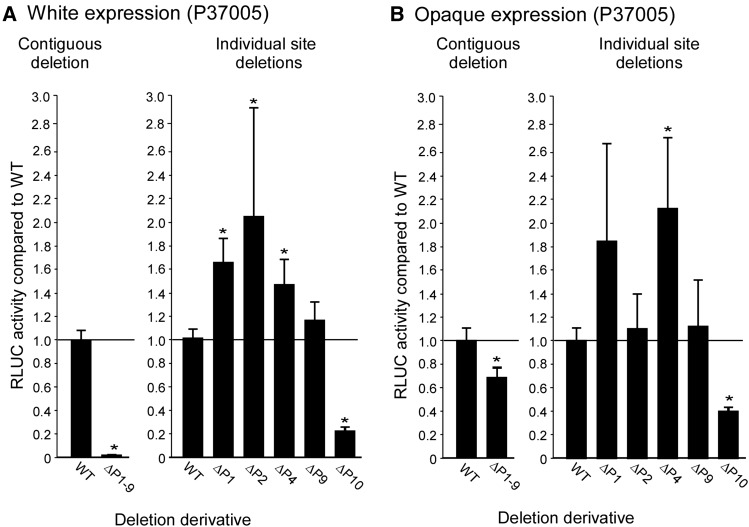
RLUC activity of select deletion derivatives generated in the a/a strain P37005, compared to the wild type (WT) derivative containing the full length upstream region of EFG1. (A) RLUC activity in the white phase of a contiguous deletion from −8860 bp through binding site 9 (ΔP1-9) and five targeted deletions of transcription factor binding sites. (B) RLUC activity in the opaque phase of the contiguous and targeted deletions (p < 0.05; two-tailed Mann–Whitney nonparametric test). RLUC, Renilla reniformis luciferase; WT, wild type.